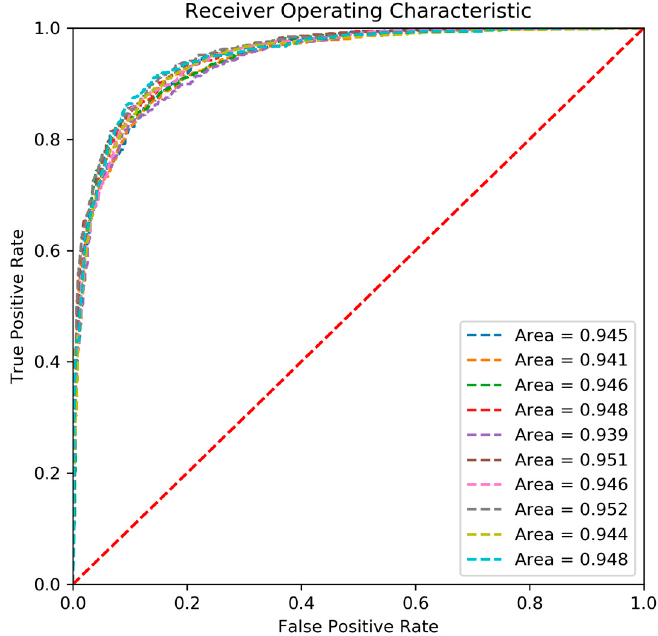
Figure 3. Receiver Operating Characteristic curve of prediction results on the 10 independent validations by Random Forest model.